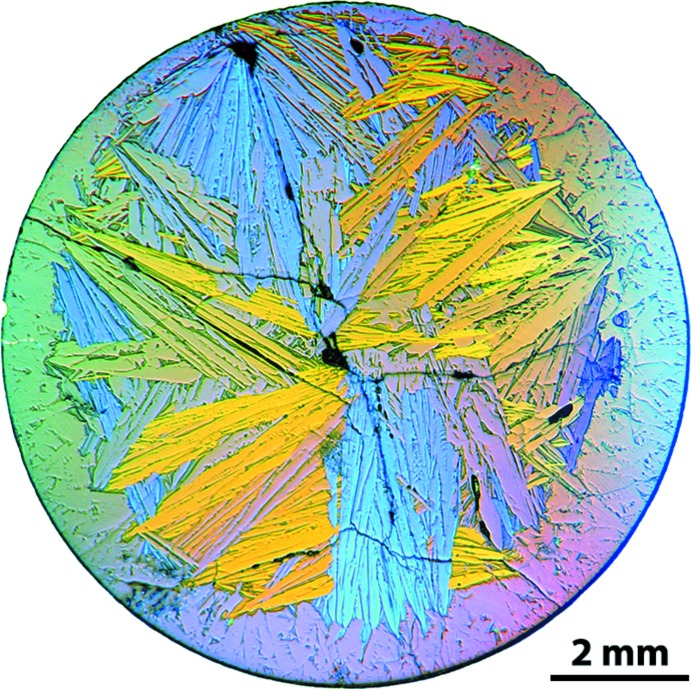
Cross-polarized light optical micrograph of a cross-sectioned sample disc after polishing showing the crystals within the core and the amorphous rim around the perimeter.